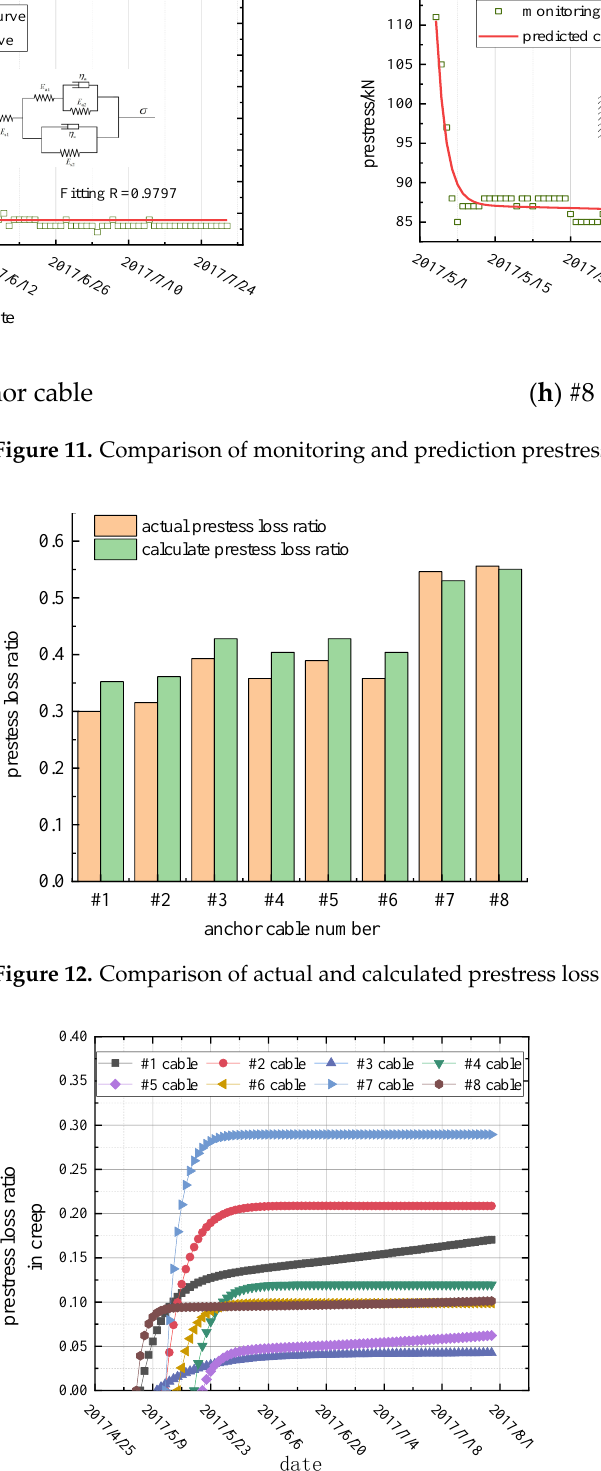
Figure 12. Comparison of actual and calculated prestress loss ratio of the anchor cable.